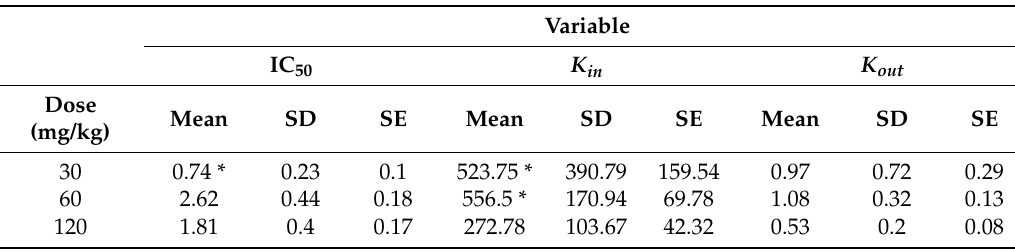
Table 4. PK–PD parameters estimation for the treatment effect of GE by the application of the E max model in AA rats.